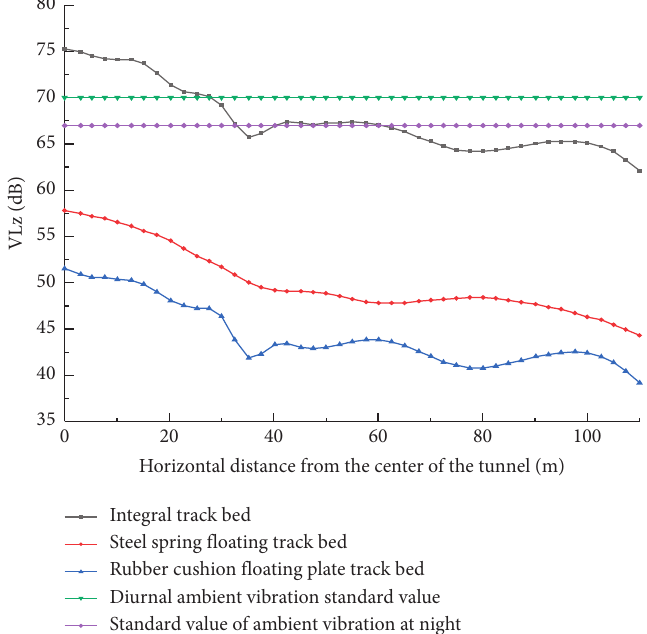
Figure 18: The variation of Z vibration level with horizontal distance.